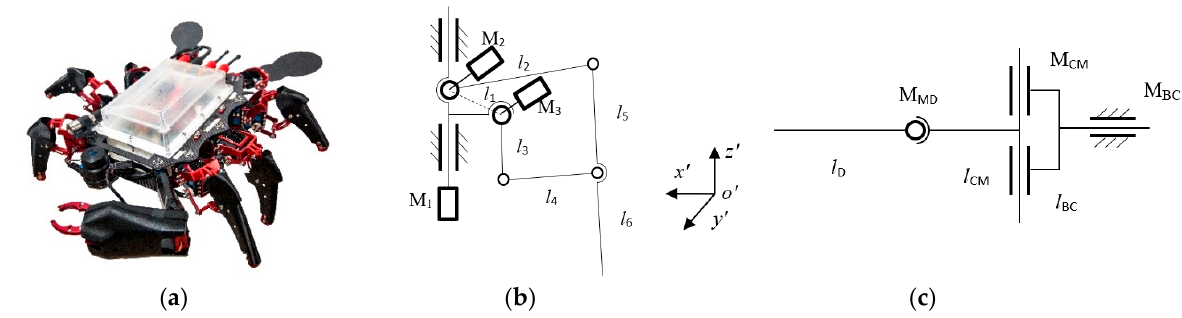
Figure 5. The structure design of the crab robot. ( a ) is the robot. ( b ) is the diagram of the leg link mechanism. ( c ) is the link mechanism diagram of the swimming leg. The control module was composed of a steering gear driver and a central controller.